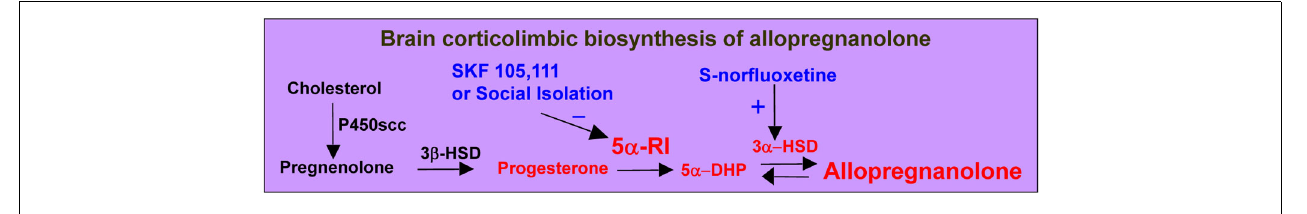
allopregnanolone into 5 α -DHP (oxidative reaction). 17 β -( N , N -diisopropylcarbamoyl)-androstan-3,5-diene-3-carboxylic acid (SKF 105,111) is a potent competitive 5 α -RI inhibitor (Cheney et al., 1995). S -norfluoxetine stimulates the accumulation of allopregnanolone likely by targeting 3 α -HSD (Griffin and Mellon, 1999). P450 scc, P450 cholesterol side-chain cleavage; 3 β -HSD, 3 β -hydroxysteroid